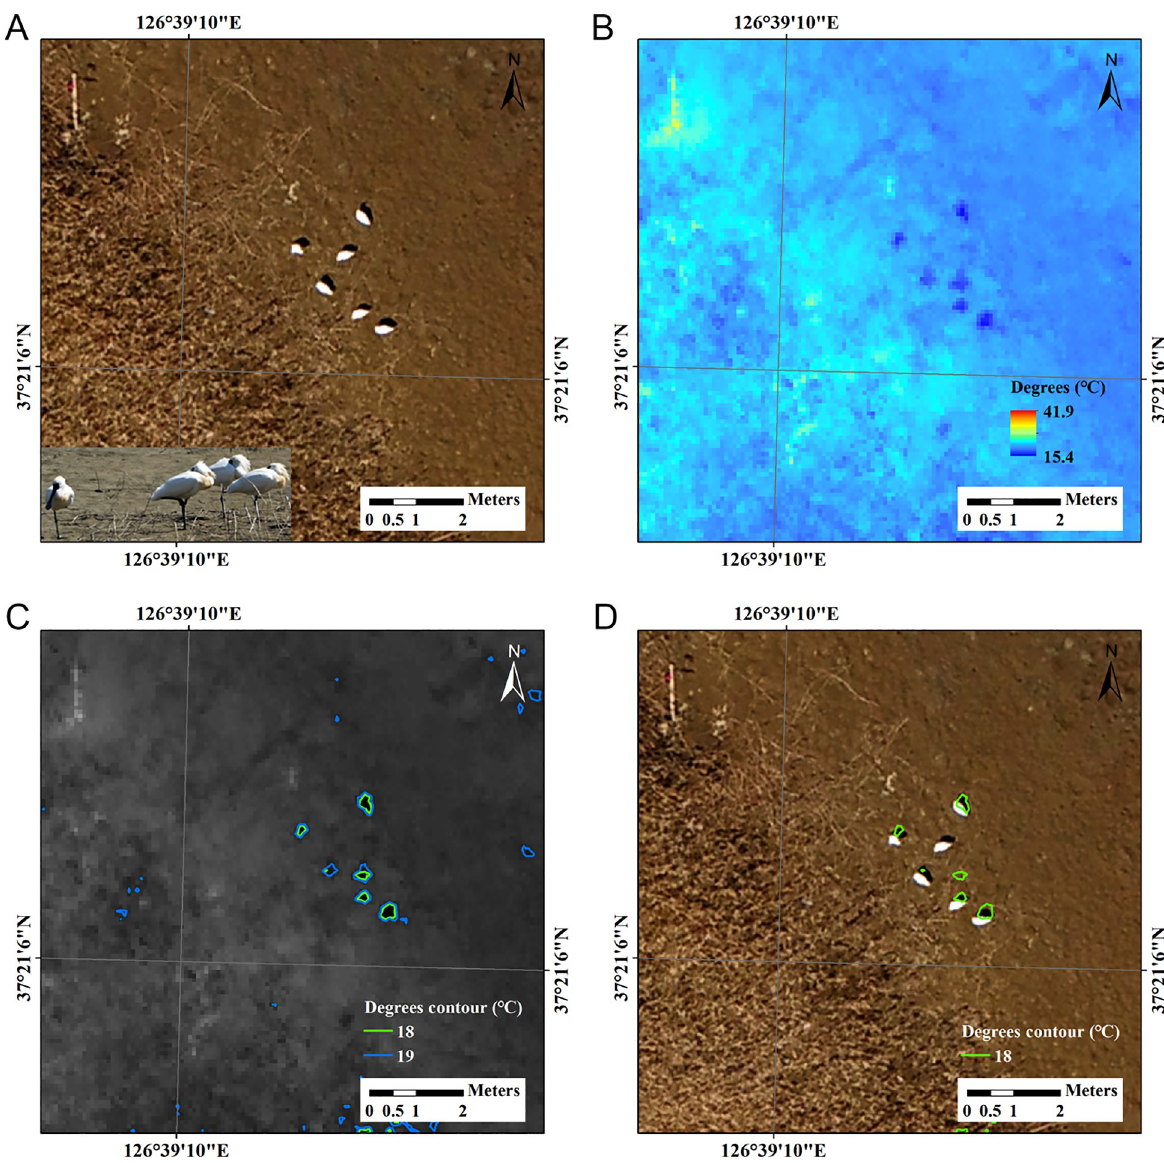
Fig 8. A blind survey with UAV images of white objects in a mud flat area. (A) Zoomed RGB mosaicked image at 110 m height. (B) Coregistered thermal image at the same spot with the RGB image. (C) Selected contours using an 18˚C temperature threshold on a flock of six spoonbills provided countable round shape figures. (D) Selected temperature overlay on the zoomed RGB mosaicked image.